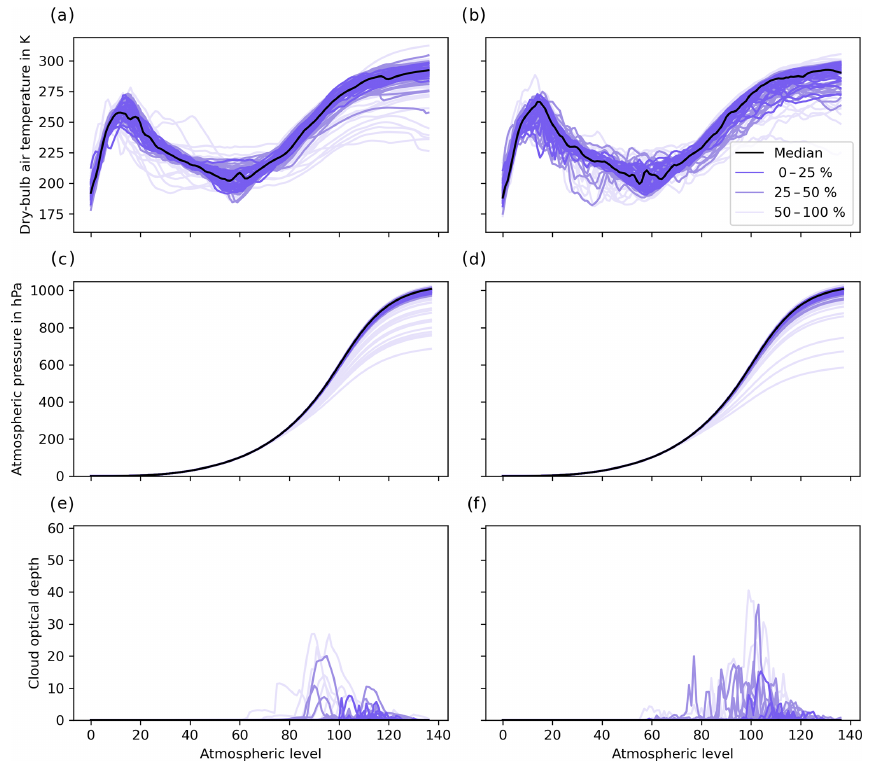
Figure 4. Profiles of (a, c, e) real NWP-SAF and (b, d, f) Gaussian-copula-generated data for (a–b) dry-bulb air temperature, (c–d) atmo- spheric pressure, and (e–f) cloud optical depth. The median profile is shown in black, with a random selection of 90 profiles grouped in batches of 3 (i.e. each having 30 profiles) for the central 0%–25%, outer 25%–50%, and 50%–100% calculated with band depth statistics (López-Pintado and Romo,